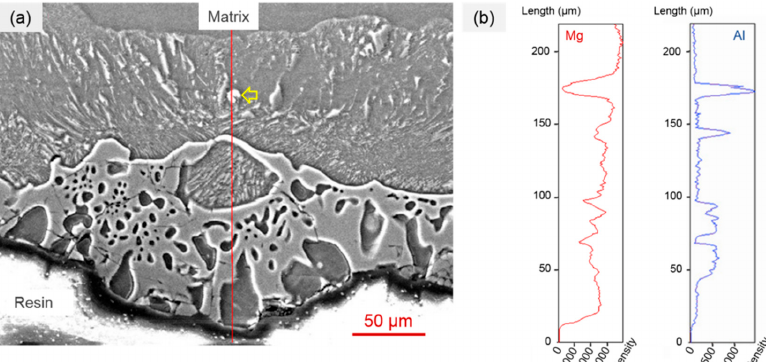
ff usion alloyed coating ( a ) and relative element distribution 3 Figure 3. The cross-section of partial as-di ( b ) on the line shown in ( a ). The arrow in ( a ) indicates an external Al-rich